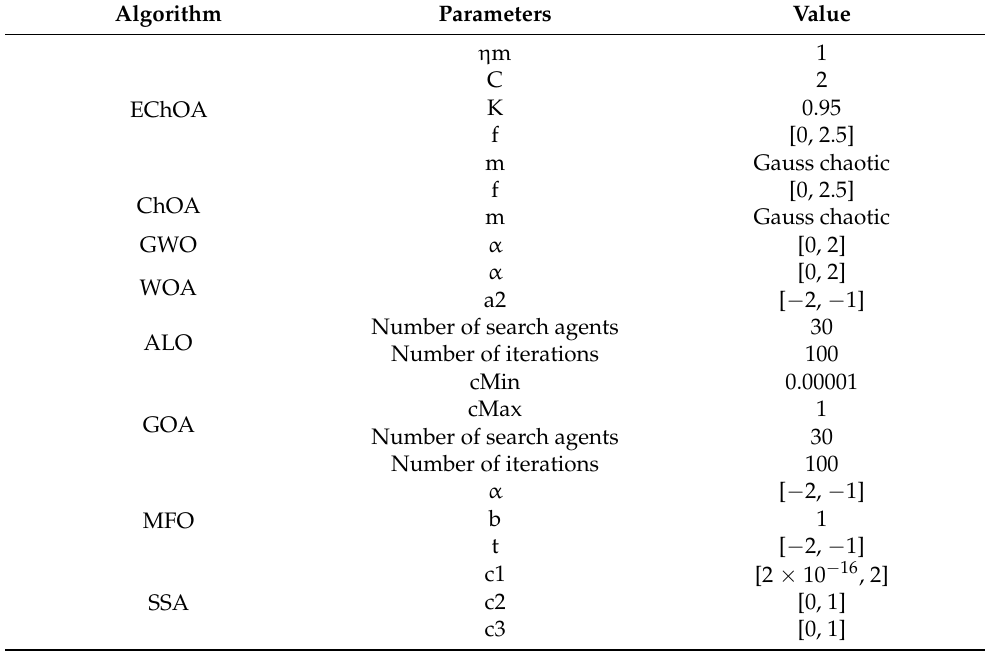
Table 2. Parameter settings of different